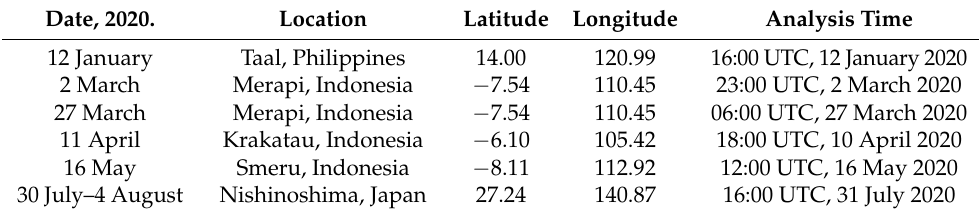
Table 3. Volcanic eruptions in